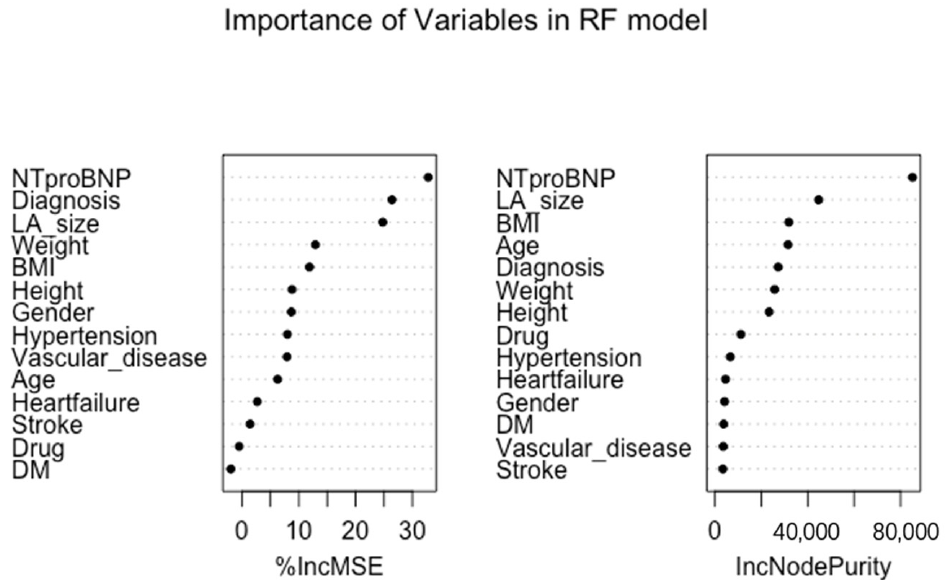
Figure 4. The importance of variables in Random Forest model. BMI: body mass index; DM: diabetes mellitus.